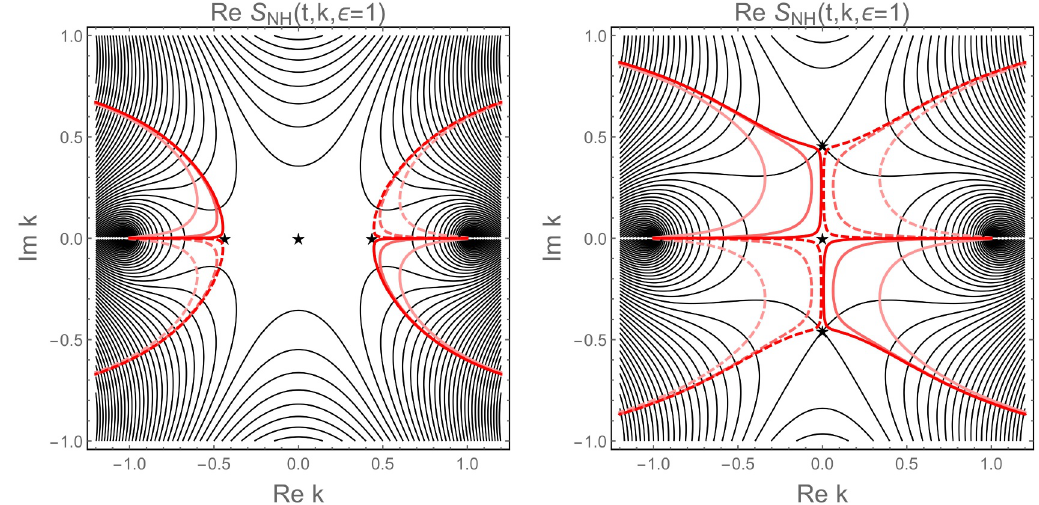
Figure 5 . For s = 1 , level plot of Re S NH ( t, k ) for (cid:15) = 1 , superimposed with the steepest descent contours emanating from the k = 0 hydrodynamic saddle for different values of (cid:15) = e iθ . Solid red lines, from lighter to darker, correspond to θ = 2 . 5 × 10 − 3 , 2 . 5 × 10 − 4 , 2 . 5 × 10 − 5 . Dashed lines represent the negative values of θ , with the same color code. Black stars correspond to saddle point locations. Left: t = 0 . 9 . Right: t = 1 .